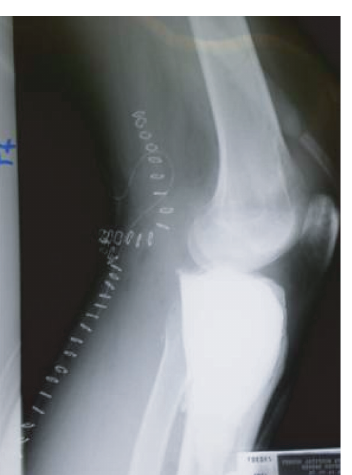
Figure 6: Postoperative lateral view of left knee showing no cortical breach/subcutaneous cement extrusion